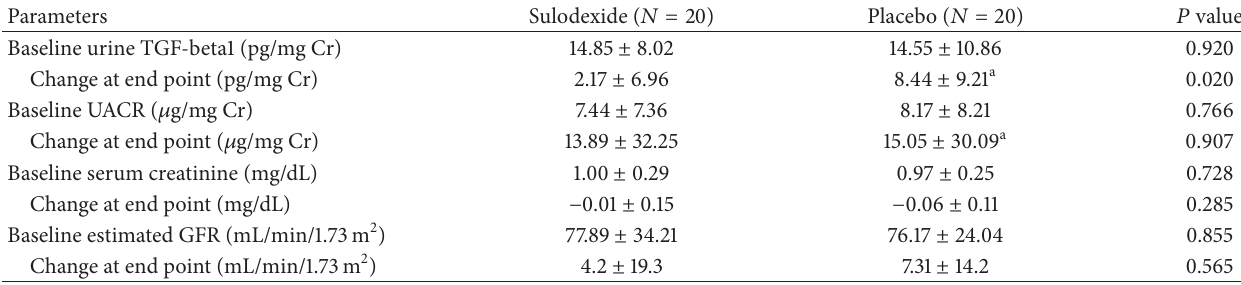
Table 3: Changes from baseline biomarkers of kidney injury.